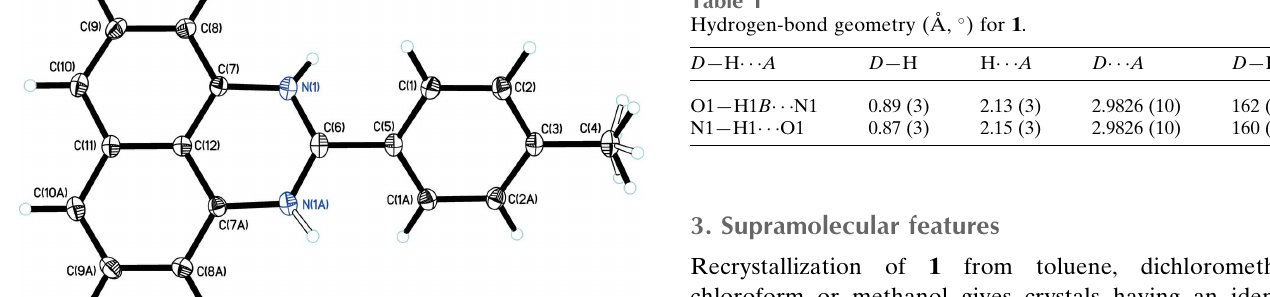
, (cid:5) y + 1 , z 4 4